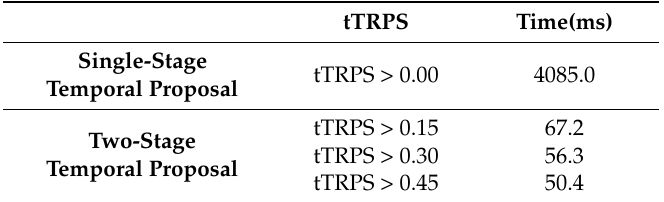
Table 5. Action-detection time depending on the increasing tTRPS.